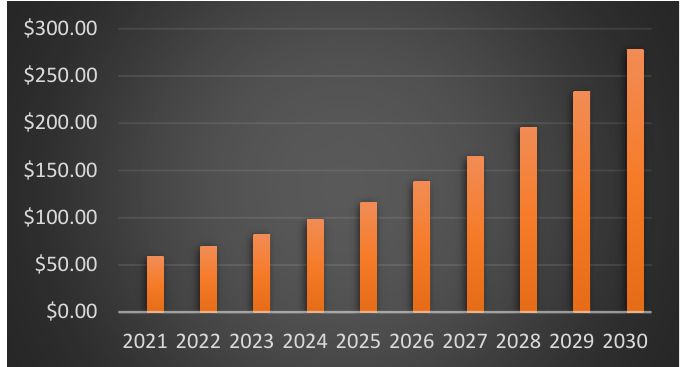
Figure 2. Lithium-ion battery market size.